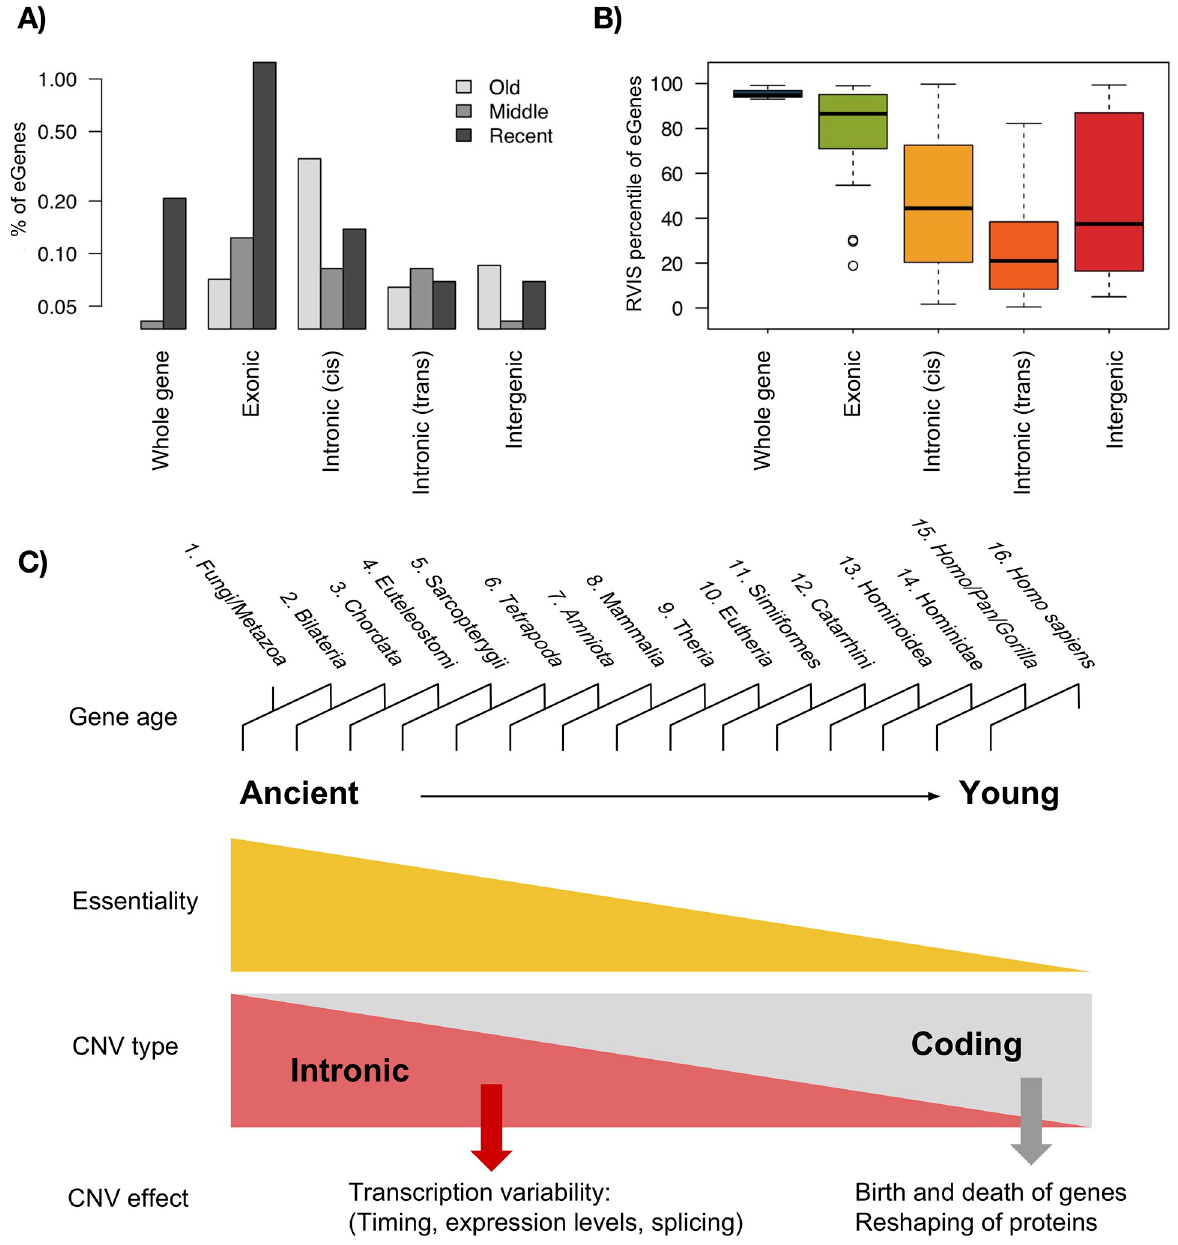
Fig 5. Impact of CNVs on genes and their evolution. (A) Percentage of genes of each group of evolutionary ages that is associated to an eCNV, for each type of eCNV. (B) RVIS percentile of the eGenes, by type of eCNV. Genes with the lowest percentile are among the most intolerant of human genes. (C) Evolutionarily ancient and young genes accumulate different kinds of structural variants. While young genes are enriched in coding deletions (which alter gene dosage or disrupt the protein, sometimes affecting gene expression), ancient genes have highly conserved coding sequence but an enrichment of deletions within their introns. As we have shown, these changes in introns can be associated with changes in gene expression, showing that although the protein is highly conserved, the expression of it can change from an individual to another due to changes in